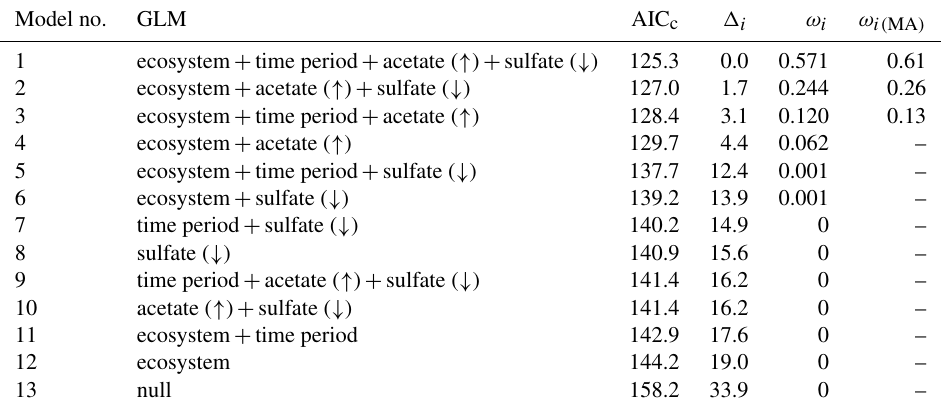
Table 3. Generalized linear models (GLMs) wherein log-transformed CH 4 production rate is the response variable and ecosystem type (non- tidal freshwater or tidal brackish), time period (June or August), porewater acetate level, and total sulfate availability are potential factors. Positive ( ↑ ) or negative effects ( ↓ ) of continuous factors are indicated. Models are ranked in order of the lowest Akaike information criterion corrected for low samples sizes (AIC c ) along with delta AIC c ( (cid:49) i ) and Akaike weights ( ω i ) before and after model averaging (MA). Models with a (cid:49) i larger than 4 were not included in the model averaging. The three models with a larger AIC c than the null model (intercept only) are not presented. Model no.